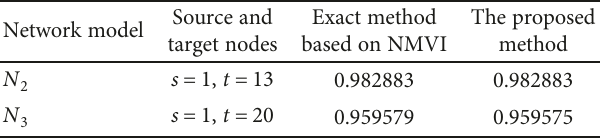
). Comparative results. s − t